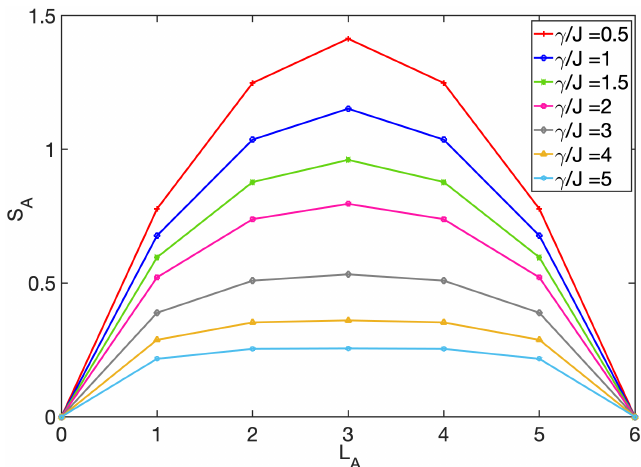
Figure 3: Saturation value of entanglement entropy S ferent subsystem size L . Different curves have different γ in the unit of J . Here, A = 6, N = 3, U / J = N s b